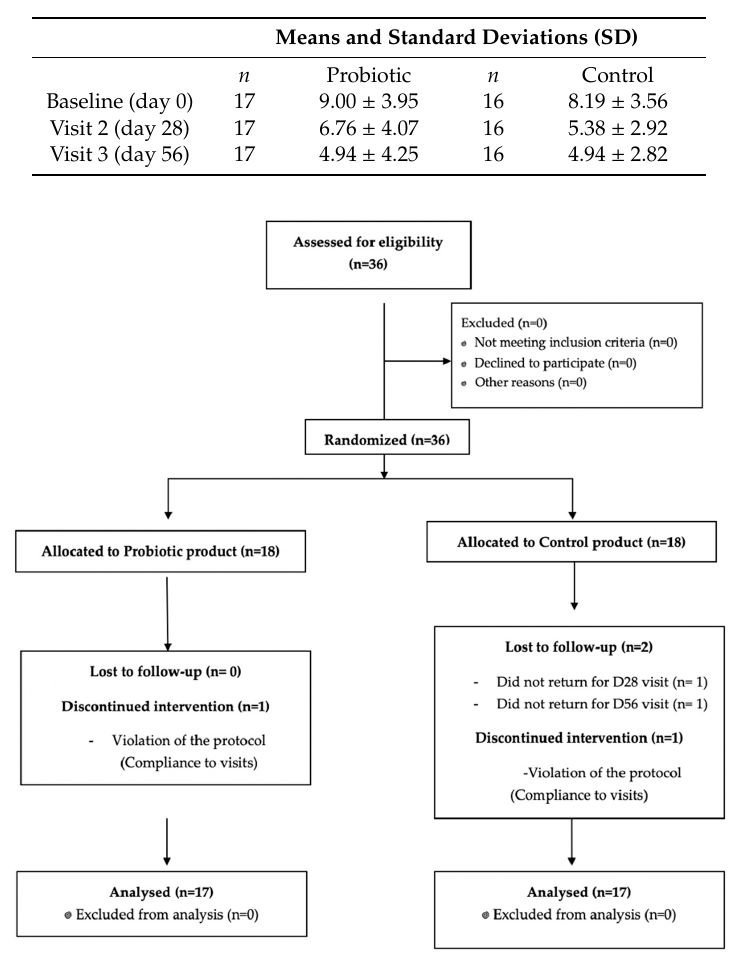
Figure A1. CONSORT flow diagram.